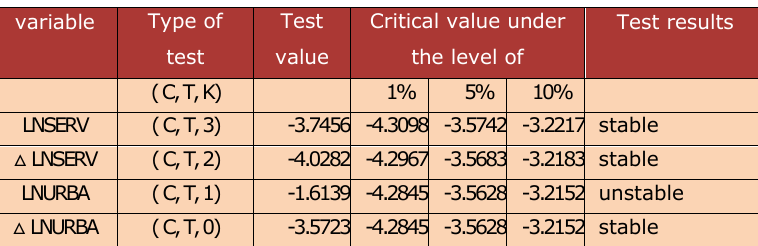
Table 2. ADF test results for each variable time